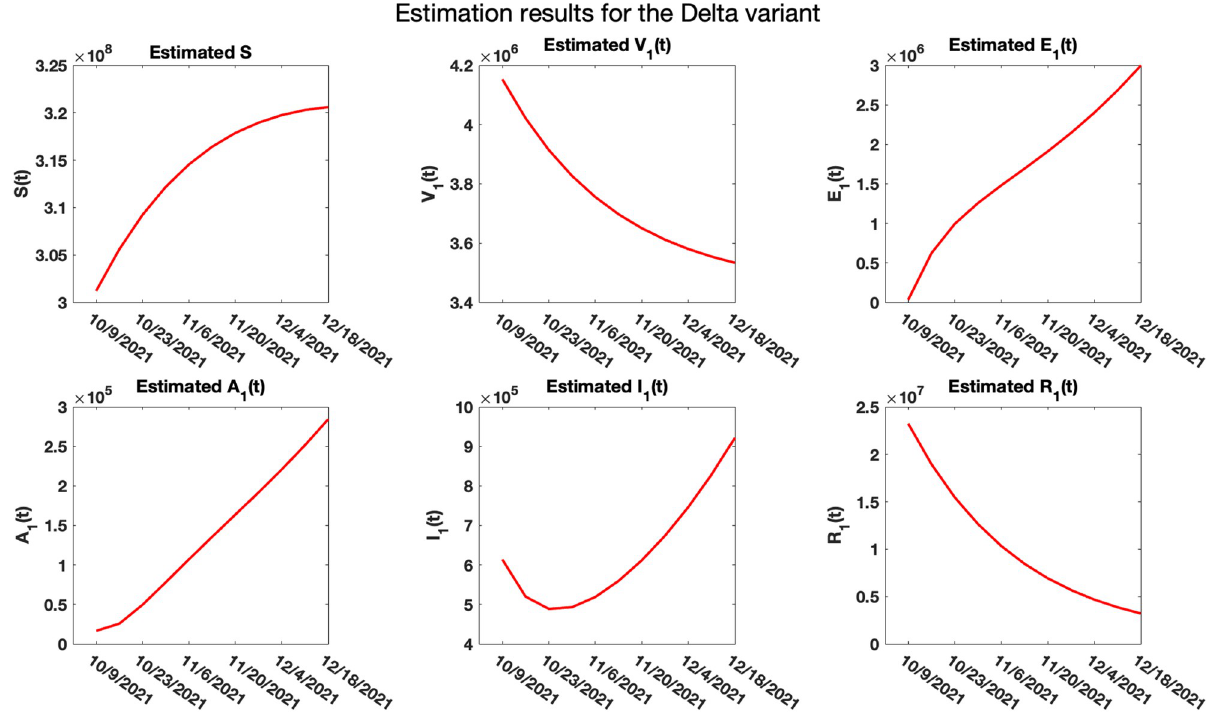
Fig 10. Estimated trajectory path for S , V 1 , E 1 , A 1 , I 1 , and R 1 for the Delta variant. The analysis suggests that the trajectories of the population of those receiving vaccination against the delta variant and those recovering from the variant are decreasing, while the susceptible, exposed and asymptomatic populations are increasing in the time period 10.09.2021 to 12.18.2021. The symptomatic population decreases from 10.09.2021 to 10.23.2021, after which it started increasing until the end of the analysis in 12.18.2021. The reproduction number R calculated to be